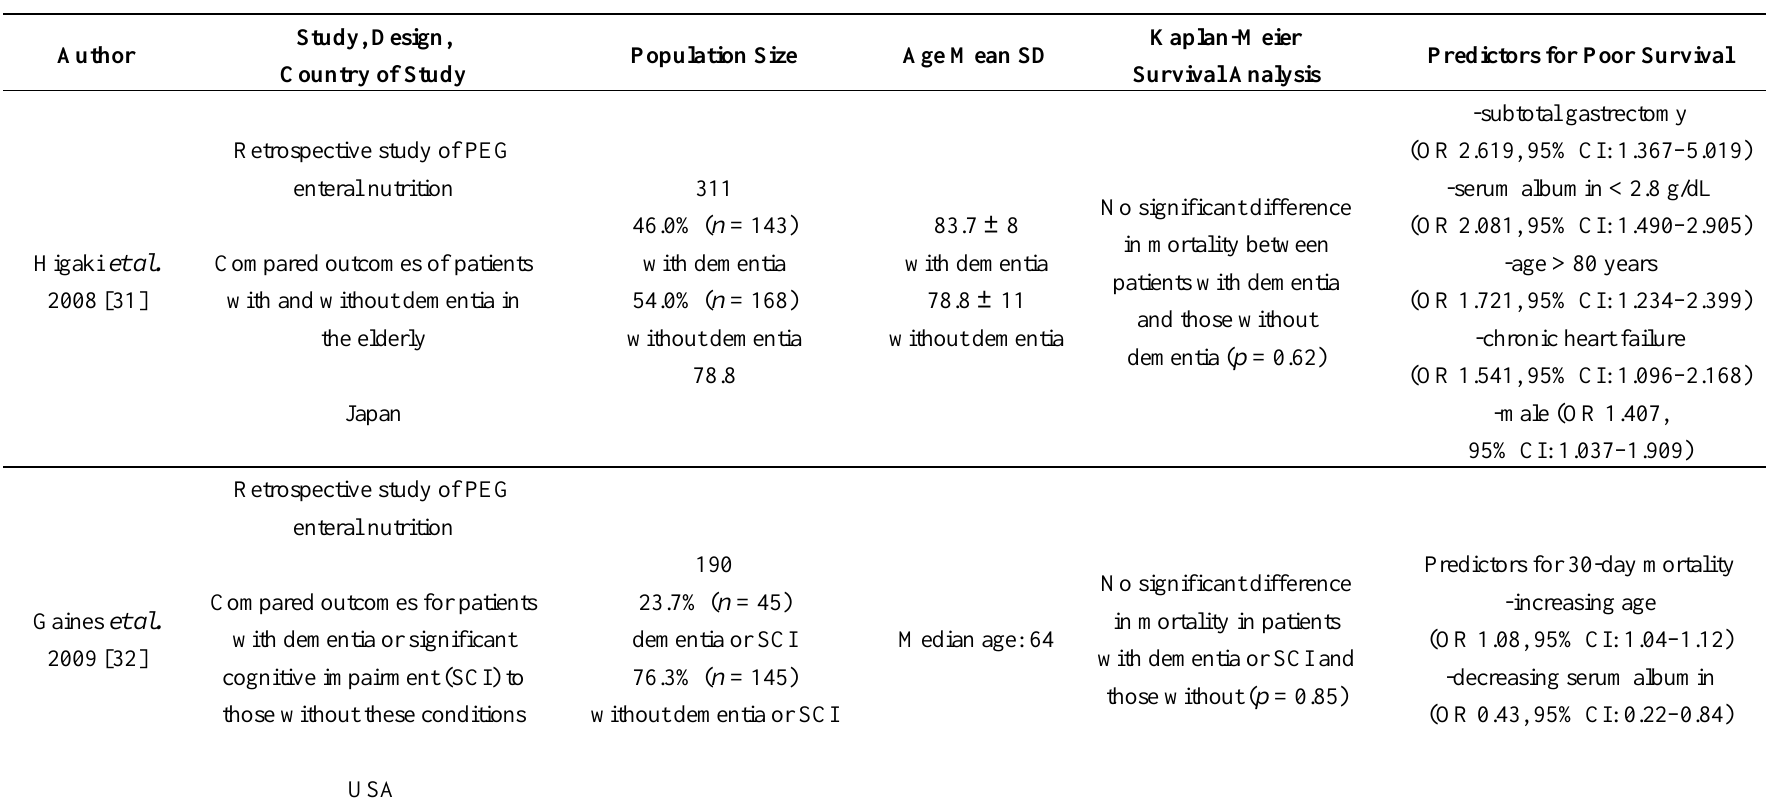
Table 2. Summary of Studies